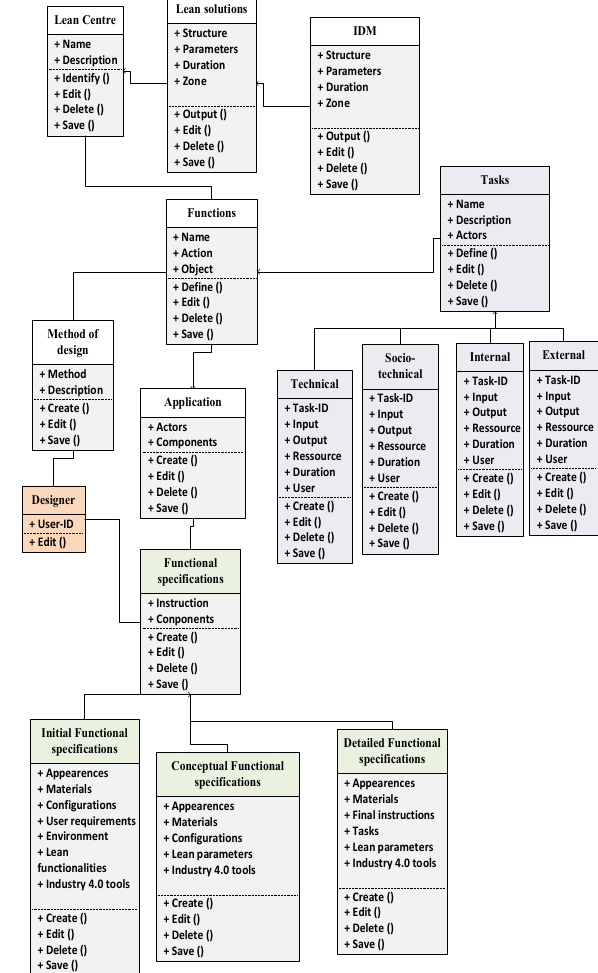
Figure 5. Class diagram of LSD